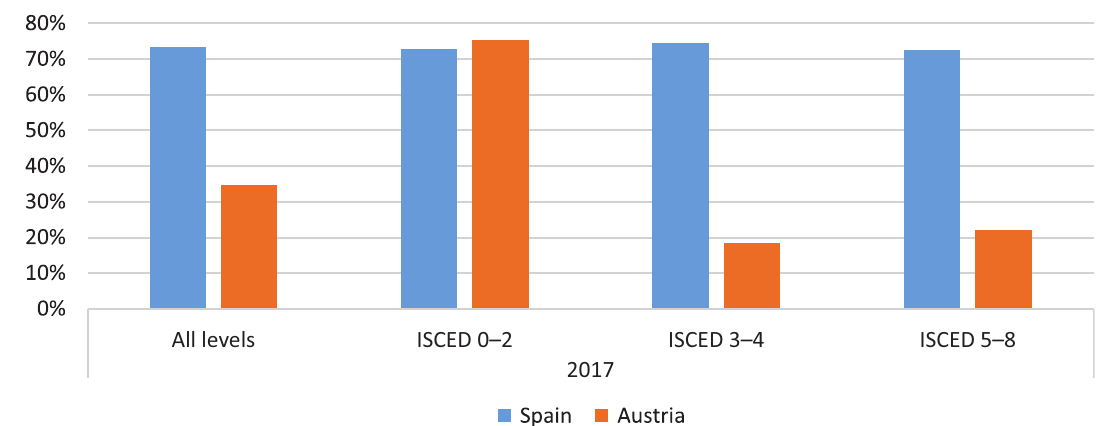
Figure 2. Temporary work rates, age group 15–24 years. Source: developed by the authors with Eurostat (2019) data. Social Inclusion, 2019, Volume 7, Issue 3, Pages